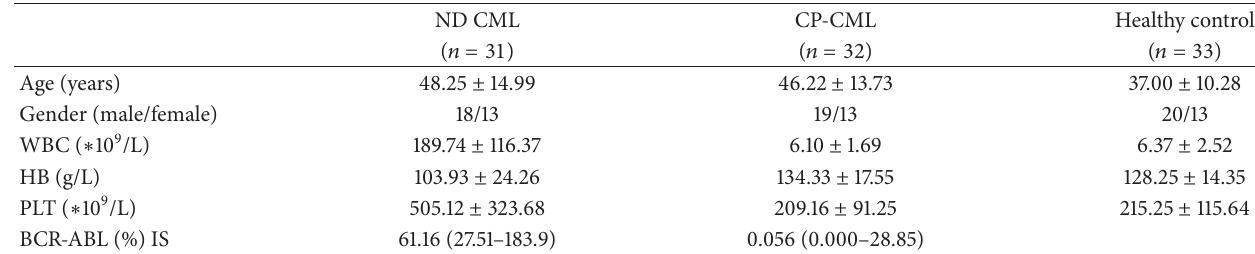
Table 1: The characteristics of